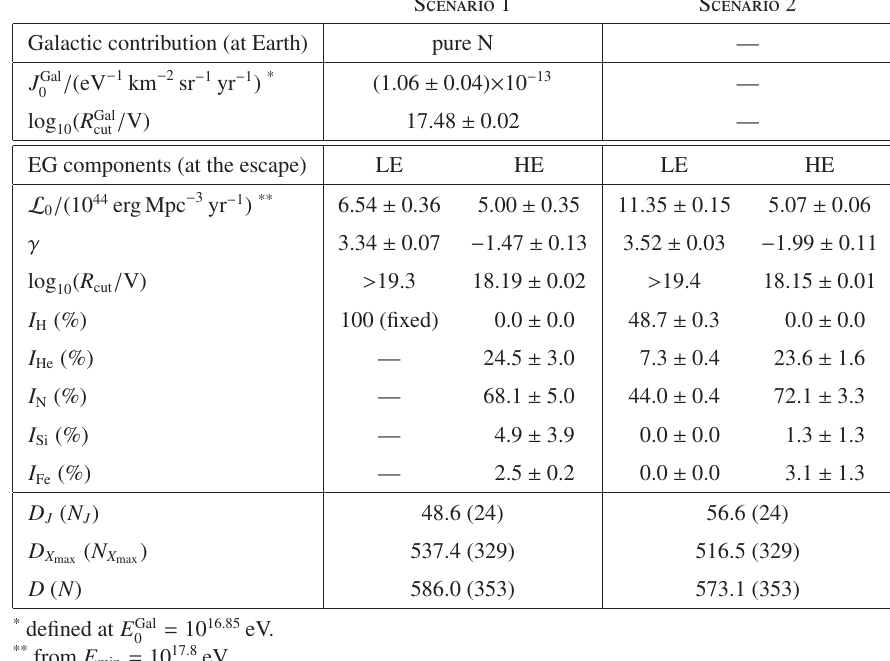
Table 1. Best-fit parameters obtained in the two reference scenarios. S cenario 1: a Galactic contribution of pure nitrogen, a low-energy extragalactic component of pure protons (LE), and a high-energy extragalactic component with a mixed mass composition (HE). S cenario 2: two mixed extragalactic components (LE and HE) overlapping in the ankle energy